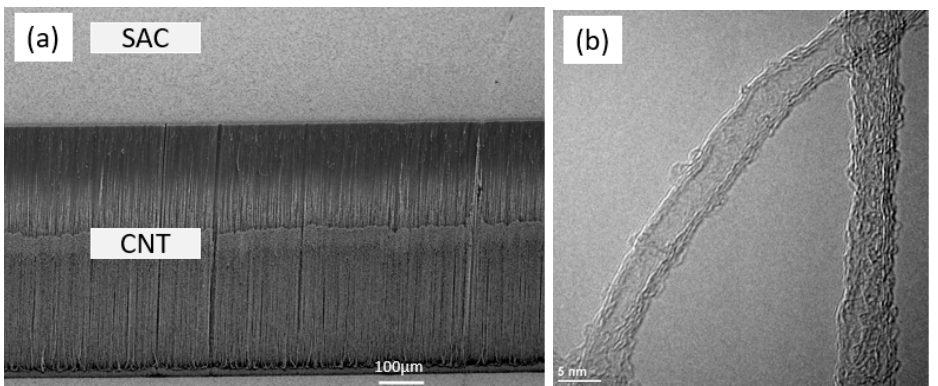
Figure 1. ( a ) Silver-copper alloy (SAC) deposited on vertically-aligned carbon nanotube (VACNT) does not affect the alignment of the array; ( b ) Transmission electron microscopy (TEM) image of as-grown CNT.